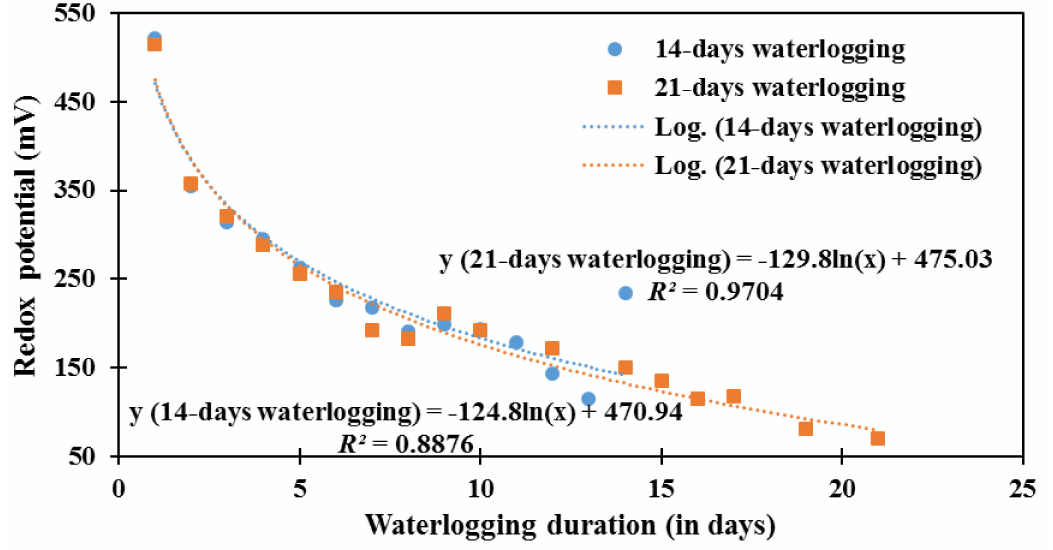
Figure 1. Changes in soil redox potential with duration of waterlogging. Regression equations are provided for the 14-day and 21-day waterlogging